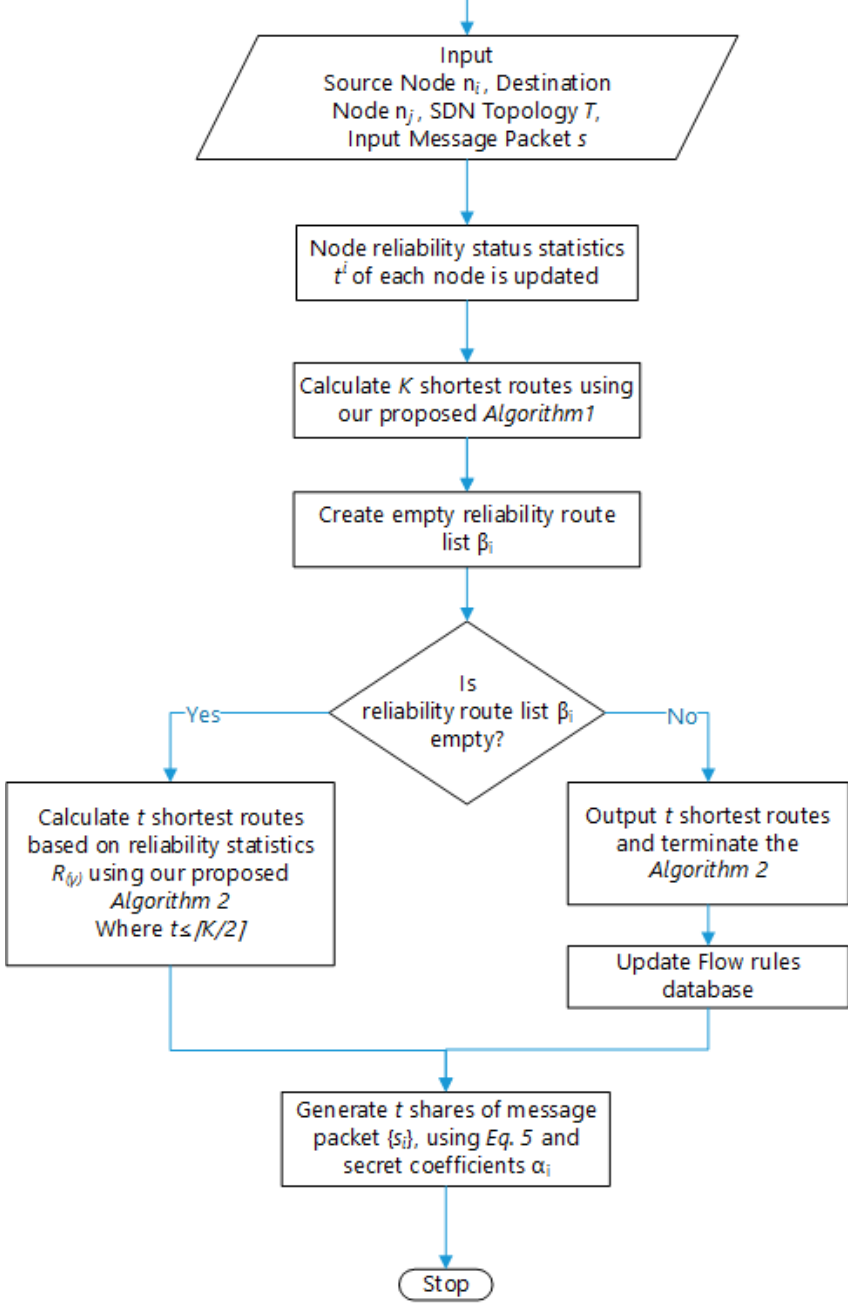
Figure 2. Flow chart for the mechanism of Obfuscation of routing paths in